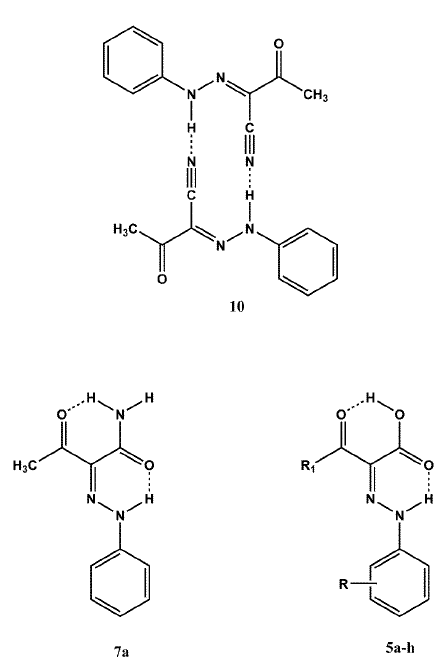
Figure 3. Dimeric structure 10 of (2 E )-3-oxo-2-(2-phenylhydrazinylidene)butanenitrile ( 6a ) and structures of (2 Z )-3-oxo-2-(2-phenylazohydrazinylidene)butanamide 7a and (2 Z )-acids 5a – h .